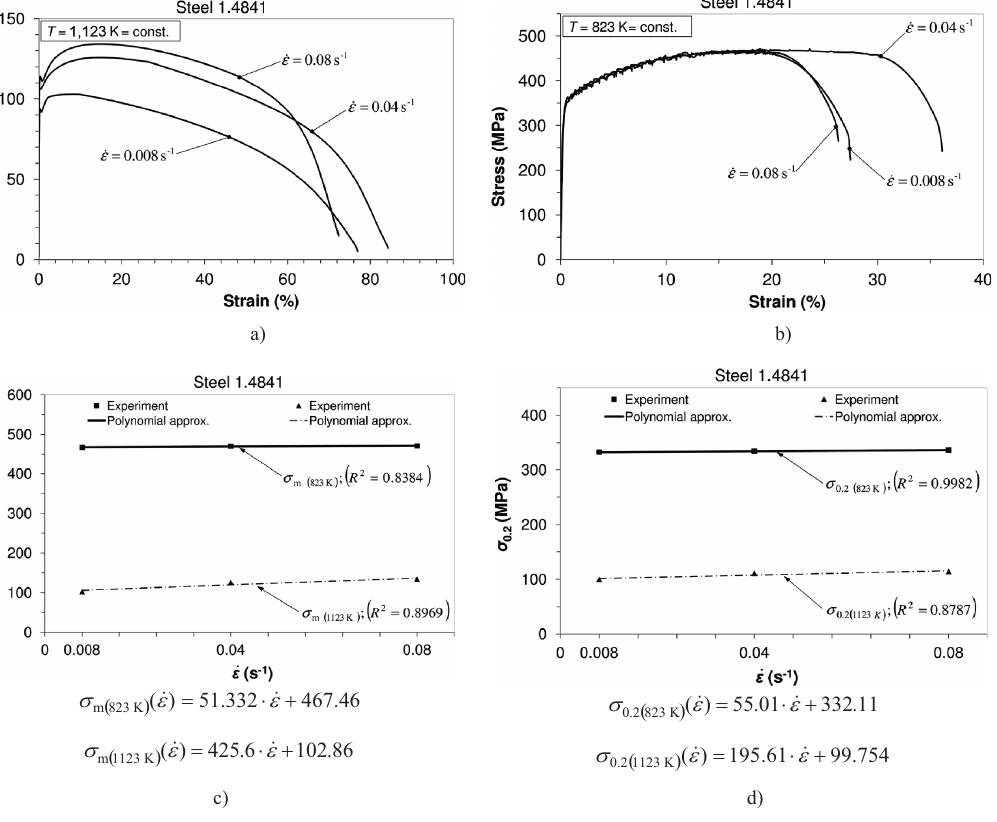
Figure 3: Steel 1.4841: Stress – strain diagrams at temperatures of 1,123 and 823 K versus strain rate. (a) Stress – strain diagrams at temperature of 1,123 K versus strain rate. (b) Stress – strain diagrams at temperature of 823 K versus strain rate. (c) Experimental values and polynomial approximation of tensile strength at temperatures of 823 and 1,123 K versus strain rate. (d) Experimental values and polynomial approximation of yield strength at temperatures of 823 and 1,123 K versus strain